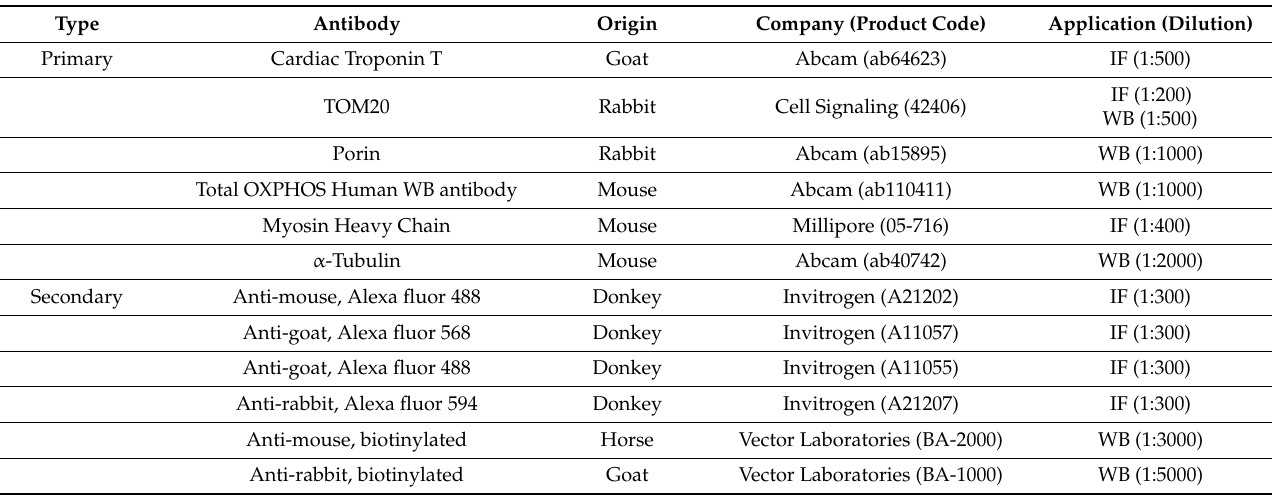
Table A1. List of antibodies used in the study.